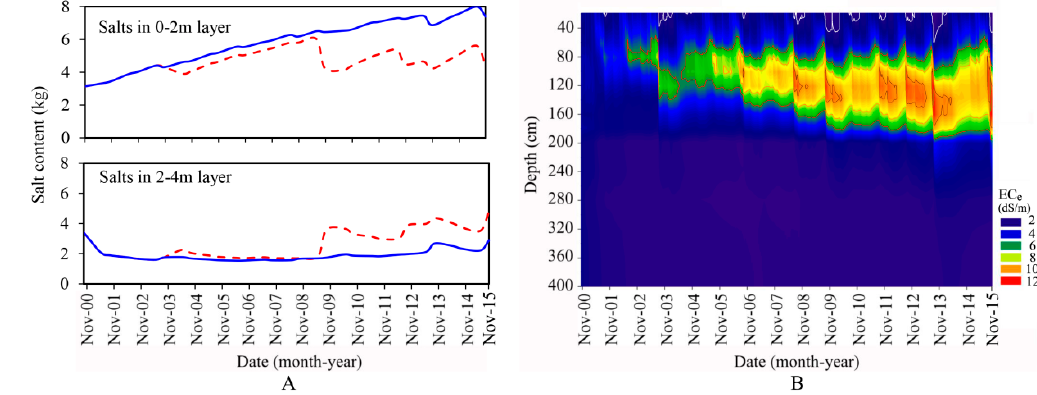
Figure 9. Comparison of salt content between S2 and S2 irrigation scenarios without heavy rainfall (>100 mm/d). ( A ) is the comparison of salt content for the 0–2-m and 2–4-m soil layers in the Hebei Low Plains study area in North China. The blue solid line represents S2 irrigation scenario without heavy rainfall; the red dashed line represents that of S2 scenario; and ( B ) is salt distribution without heavy rainfall.